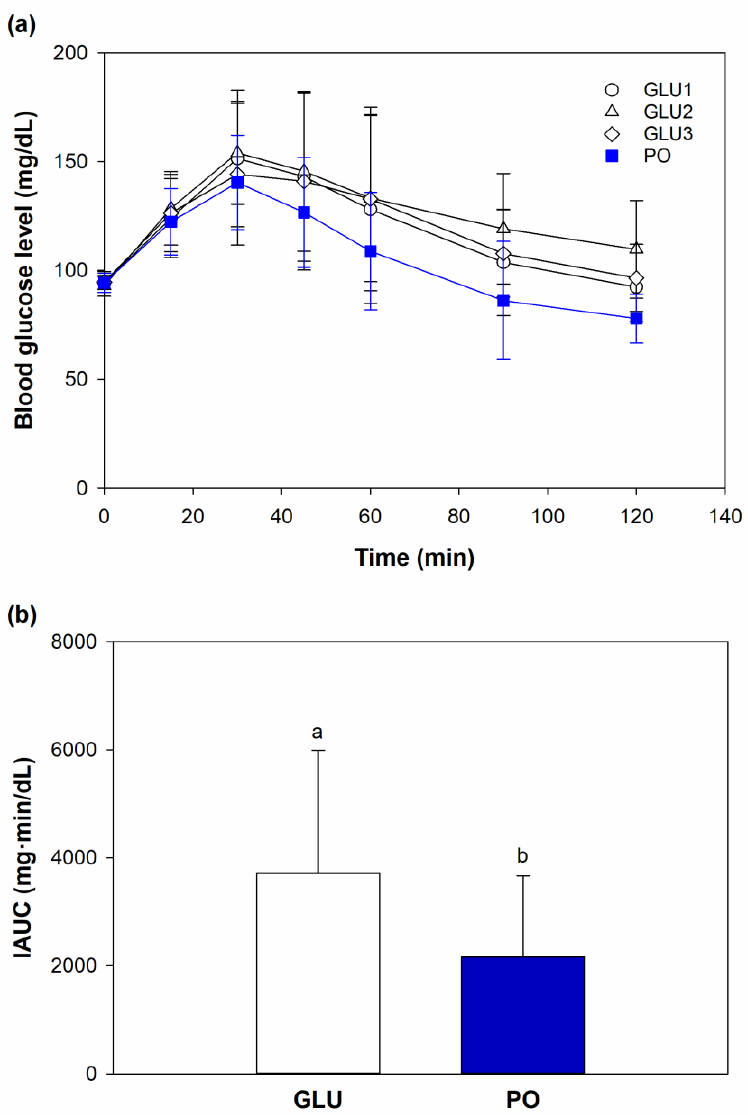
Figure 6. ( a ) Changes in blood glucose level and after ingestion of glucose standard as a reference food (GLU1, GLU2, GLU3), and date syrup prepared from juice extracted with the aid of Pectinex followed by evaporation using open heating (PO); ( b ) Incremental area under the curve after in- gestion of glucose standard (GLU) and date syrup (PO). Values are means and standard deviations of 11 subjects ( n = 11). Different superscripts indicate significant difference between means ( p < 0.05).